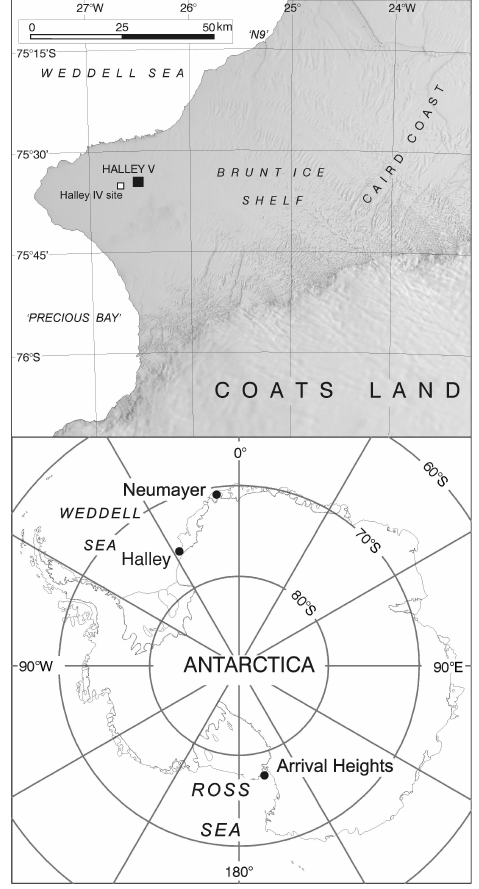
Fig. 1. Maps showing location of Halley station as well as other locations referred to in the